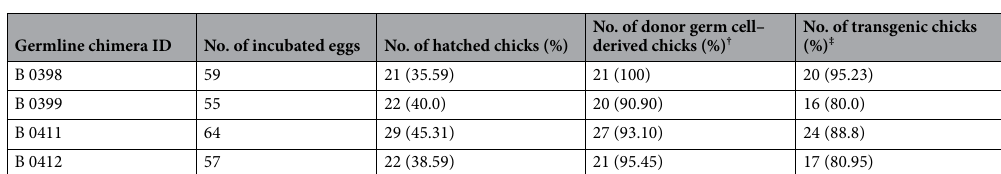
Table 2. Efficiency of germ-line transmission and transgenic chick production with MGSTII-tg donor PGCs after busulfan treatment. † The phenotype of offspring derived from donor PGCs of WL chickens ( I/I ). ‡ The percentage of donor germ cell–derived chicks that expressed